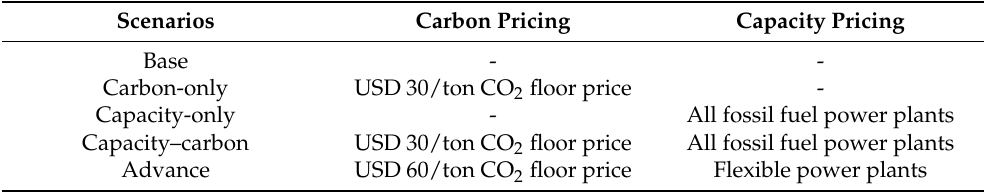
Table 3. Scenarios settings summary.